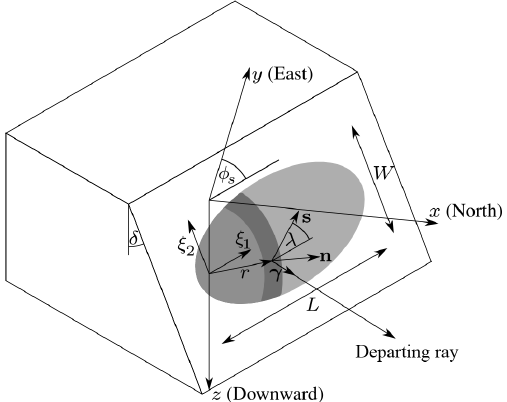
Figure A1. Set-up of the rupture model. Grey ellipse represents the rupture: light grey area is unruptured, medium grey area is slipping, and the dark grey area is after slip